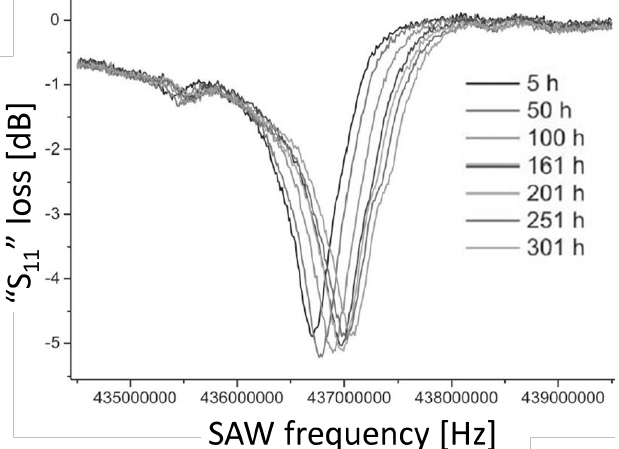
Figure 7. The S parameters measurement results as a function of frequency at 600 °C for 11 301 h [65] (copyright 2006 by the